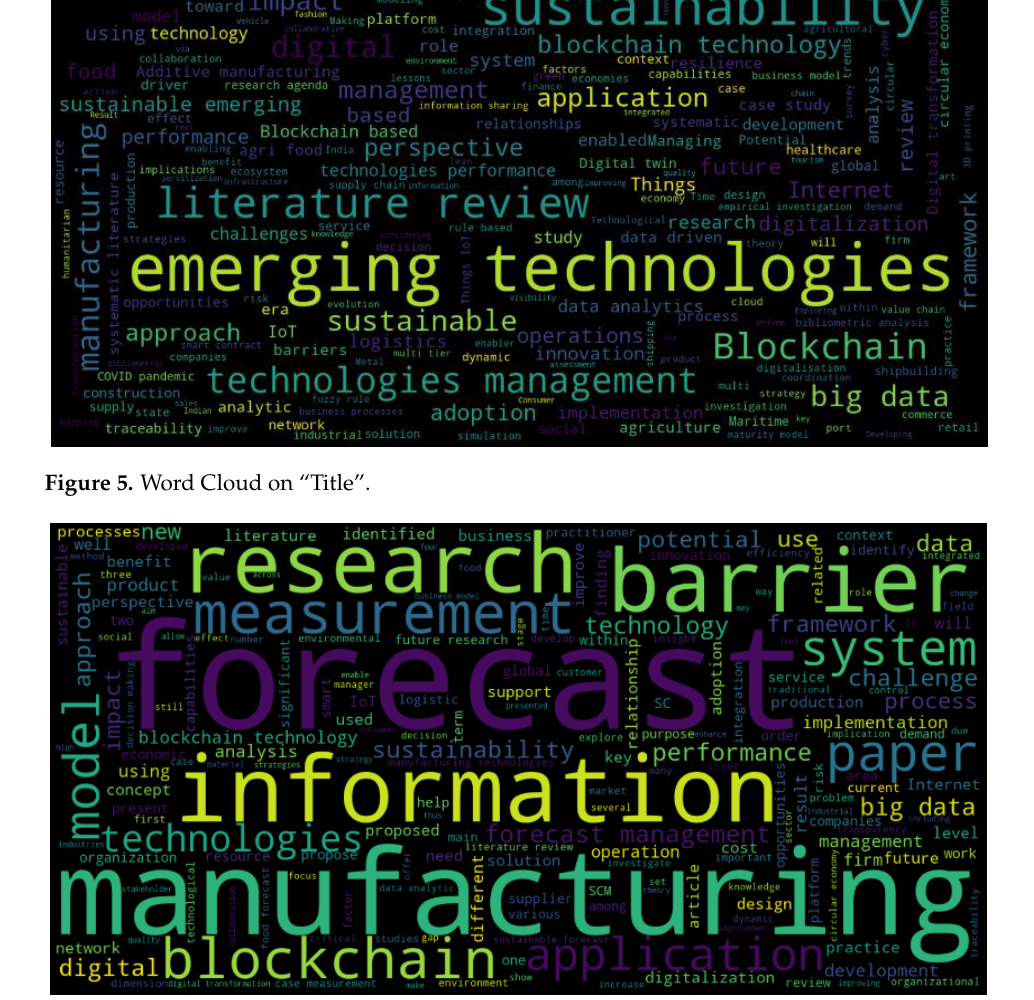
Figure 7. Word Cloud on “Keywords”.